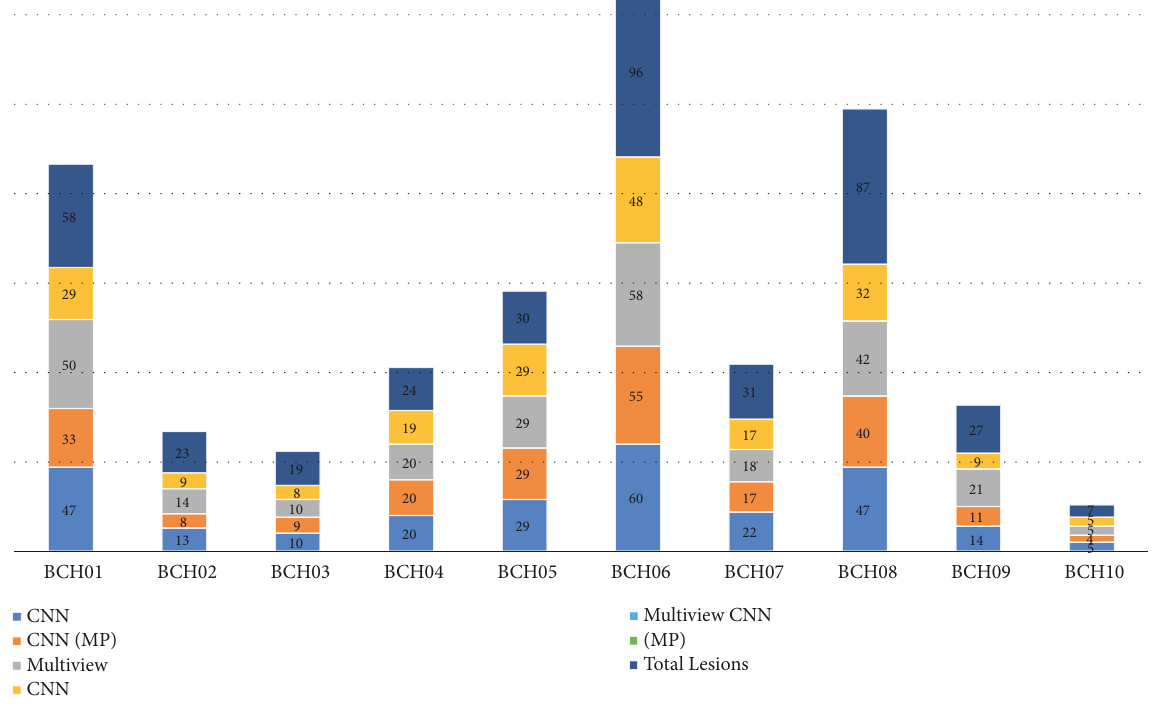
Figure 5: Number of segmented lesions. Table 3: Number of segmented